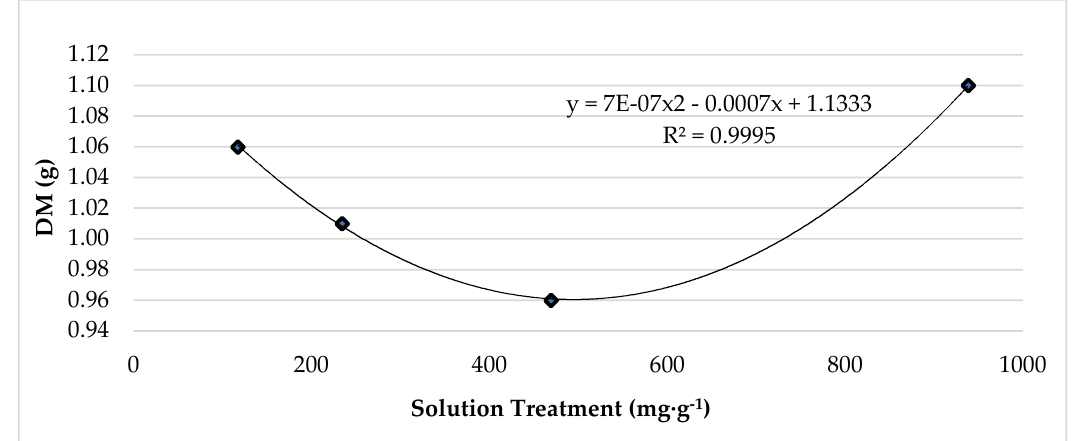
Figure 1. The effect of increasing potassium treatment on grow chamber, red ‘Lollo’ lettuce dry mass. The standard error of the mean was: Leaf DM ± 0.04.